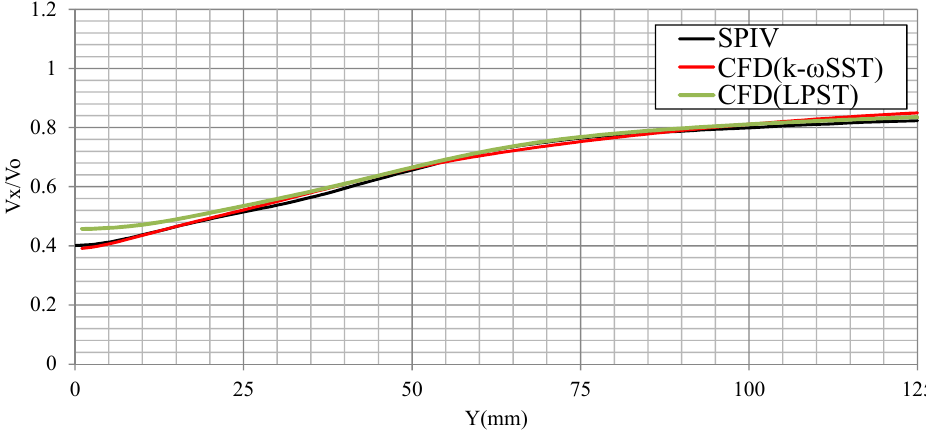
Figure 18. Axial velocity distribution of KCS along the horizontal line above propeller shaft.